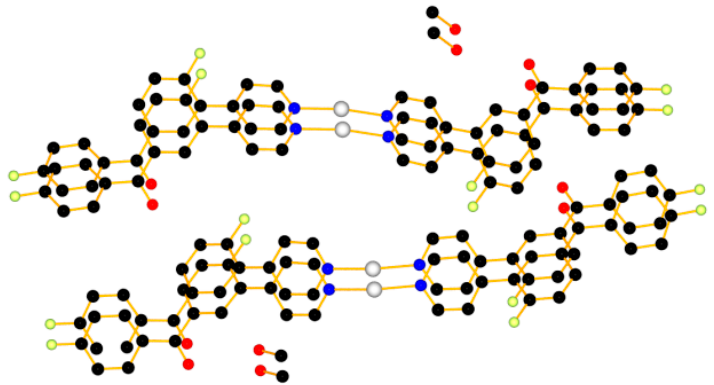
Figure 7. View of the packing of 4b . Hydrogen atoms were omitted for clarity. Different colors have been attributed to the different atoms (black: C, blue: N, red: O, yellow: P, green: F, grey: Ag).